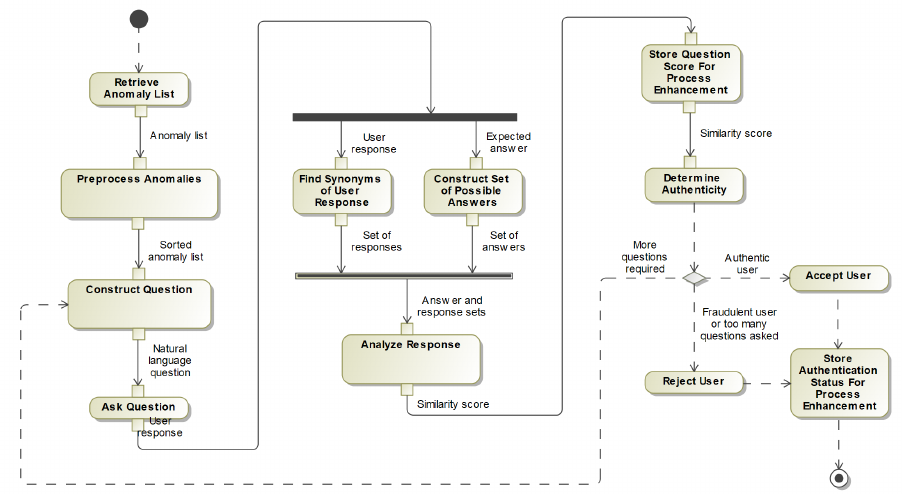
Figure 2. The overall